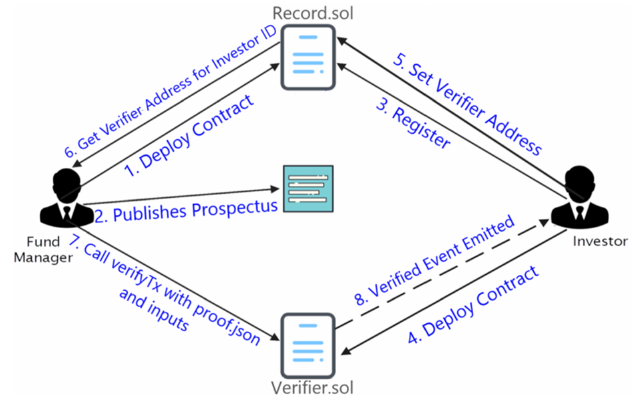
Figure 5: Protocol between Fund Manager and